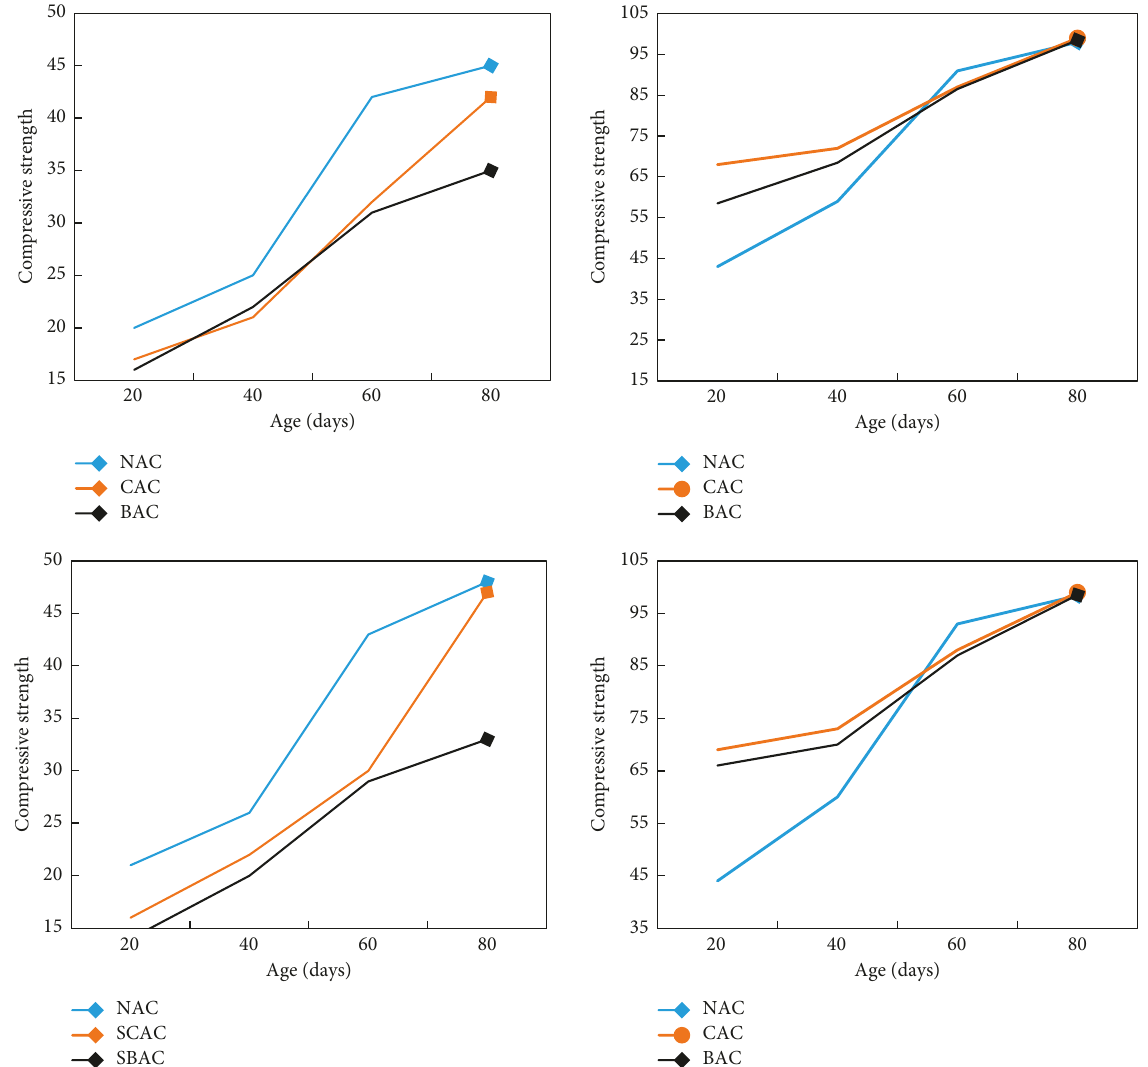
Figure 4: Test of percentage increase in compressive strength of PVA-modified recycled concrete SBAC and SCAC.